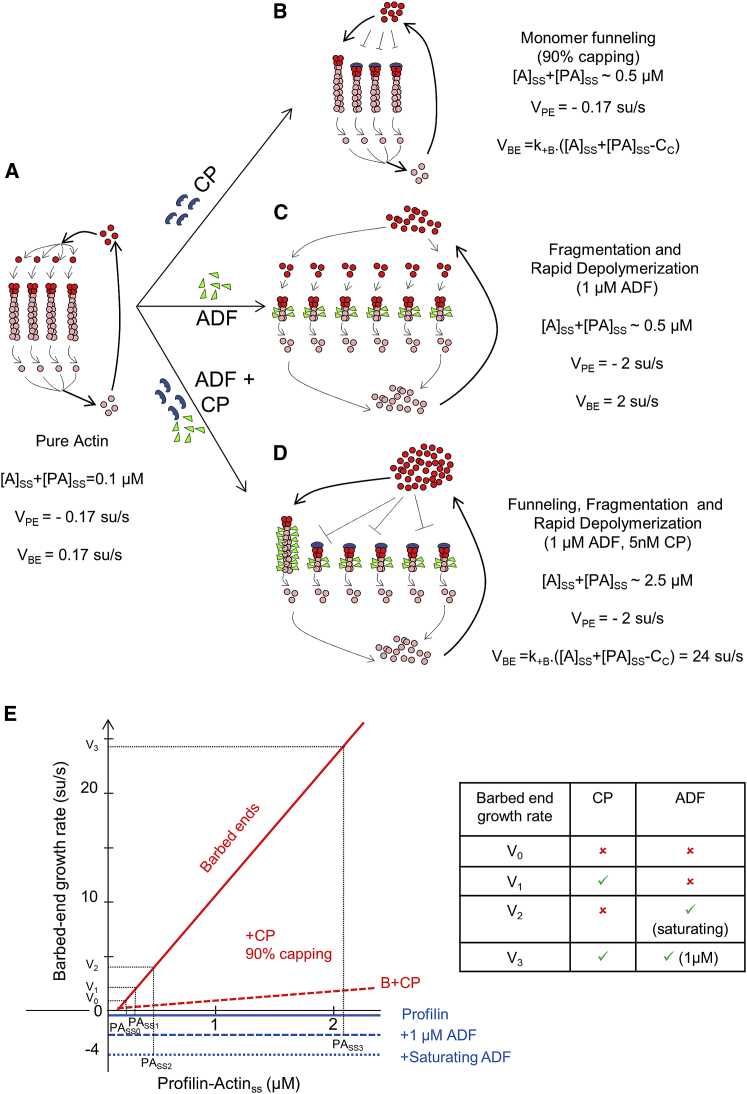
Combined Effects of ADF and CP on Barbed-End Growth Rate at Steady State(A) Control filaments (four shown) treadmill very slowly due to low steady-state polymerizable monomer (∼0.1 μM; mainly profilin-actin), at which barbed-end growth rate (VBE= k+B.([A]SS+[PA]SS − Cc); see Equations 5 and 6; STAR Methods) balances slow pointed-end depolymerization (VPE∼−0.17 su/s).(B) In the presence of CP (90% capping), all pointed ends feed a fewer number (10%) of uncapped barbed ends, which individually grow faster.(C) In the presence of ADF, enhanced pointed-end depolymerization (2 su/s at saturation by ADF) establishes a higher concentration [PASS] (0.5 μM).(D) In the presence of both ADF and capping protein (CP), [PASS] further increases and non-capped barbed ends grow faster.(E) Graphical representation of the effects of ADF and CP on the contribution of barbed- and pointed-end dynamics in establishing the steady state of actin assembly. Red and blue lines represent the change in elongation rates at filament barbed and pointed ends, respectively, versus monomeric actin concentration in the presence of 3 μM profilin. Due to the presence of profilin, pointed ends only depolymerize at constant rate: 0.17 su/s in absence of ADF (continuous line); 2 su/s in presence of 1 μM ADF (dashed line); and 5 su/s in presence of saturating ADF (dotted line). Barbed ends grow with 100% free (non-capped) barbed ends (continuous red line) or 90% capped barbed ends (dotted red line indicates bulk growth rate). The steady-state monomer concentration is first determined as the monomer concentration at which pointed end disassembly equals barbed end assembly bulk rate. The elongation rate Vi of individual barbed ends at steady state is then read on the graph as the rate of non-capped barbed end (continuous red line) at the steady-state monomer concentration. Conditions shown as examples are as follows: no regulator (V0); + 2 nM CP: (V1); + saturating ADF (V2); and + both 1 μM ADF and CP (V3).